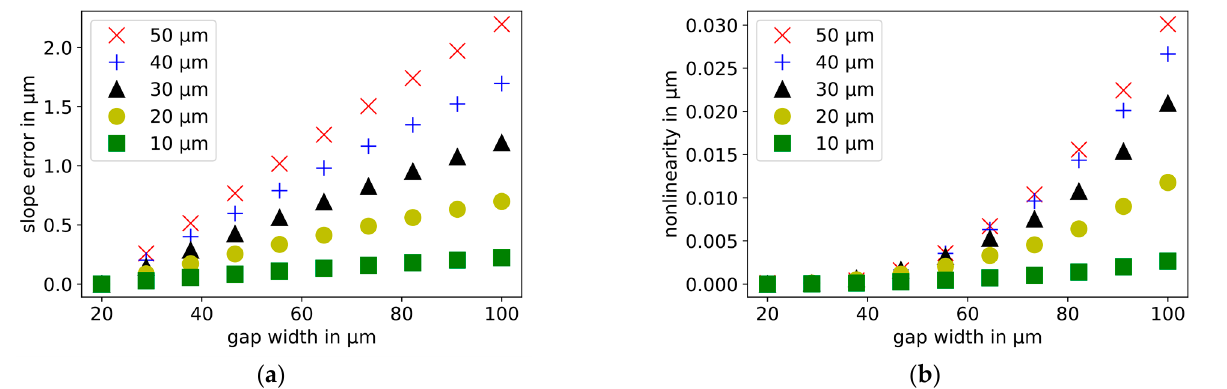
Figure 12. Influence of the relative displacement range on the influence of the width of the dielectric gap on ( a ) the normalized slope error and ( b ) the normalized nonlinearity. The further the relative displacement, the faster the slope error and nonlinearity increase with the increasing dielectric gap.